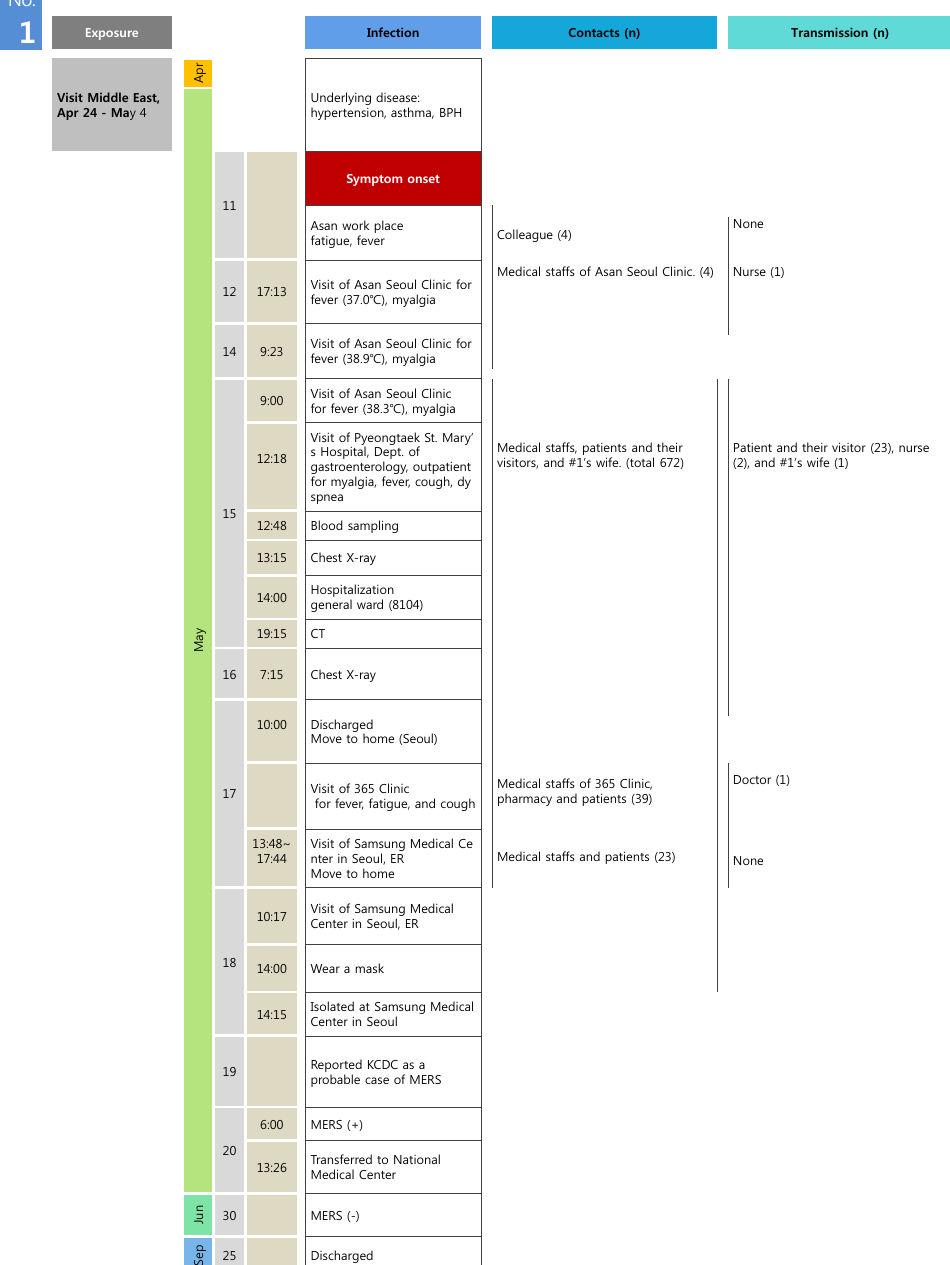
Figure 1. Main events by date for the 1st confirmed Middle East Respiratory Syndrome (MERS) case in Korea. BPH, benign prostatic hy- pertrophy; CT, computed tomography; ER, emergency room; KCDC, Korea Centers for Disease Control and